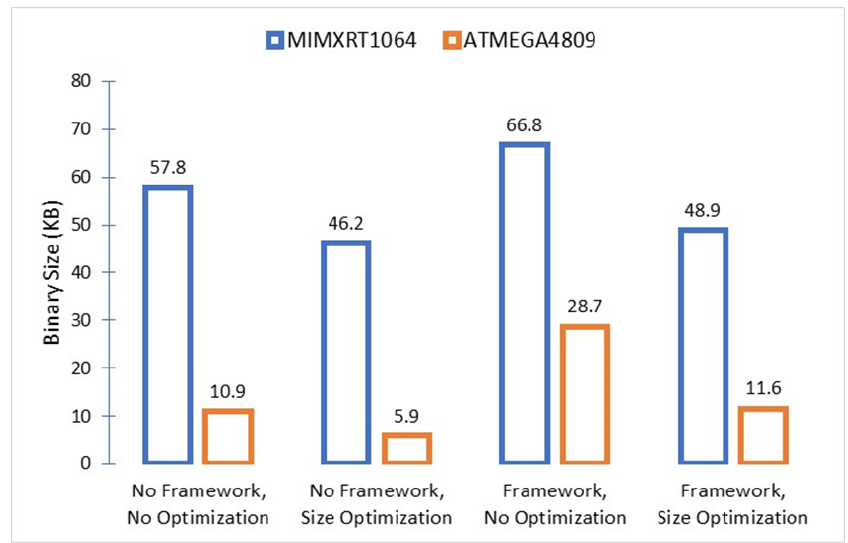
Figure 13. Binary size comparison for the 32-bit NXP microcontroller (MIMXRT1064) and for the 8-bit Microchip microcontroller (ATMEGA4809) considering four evaluated cases.